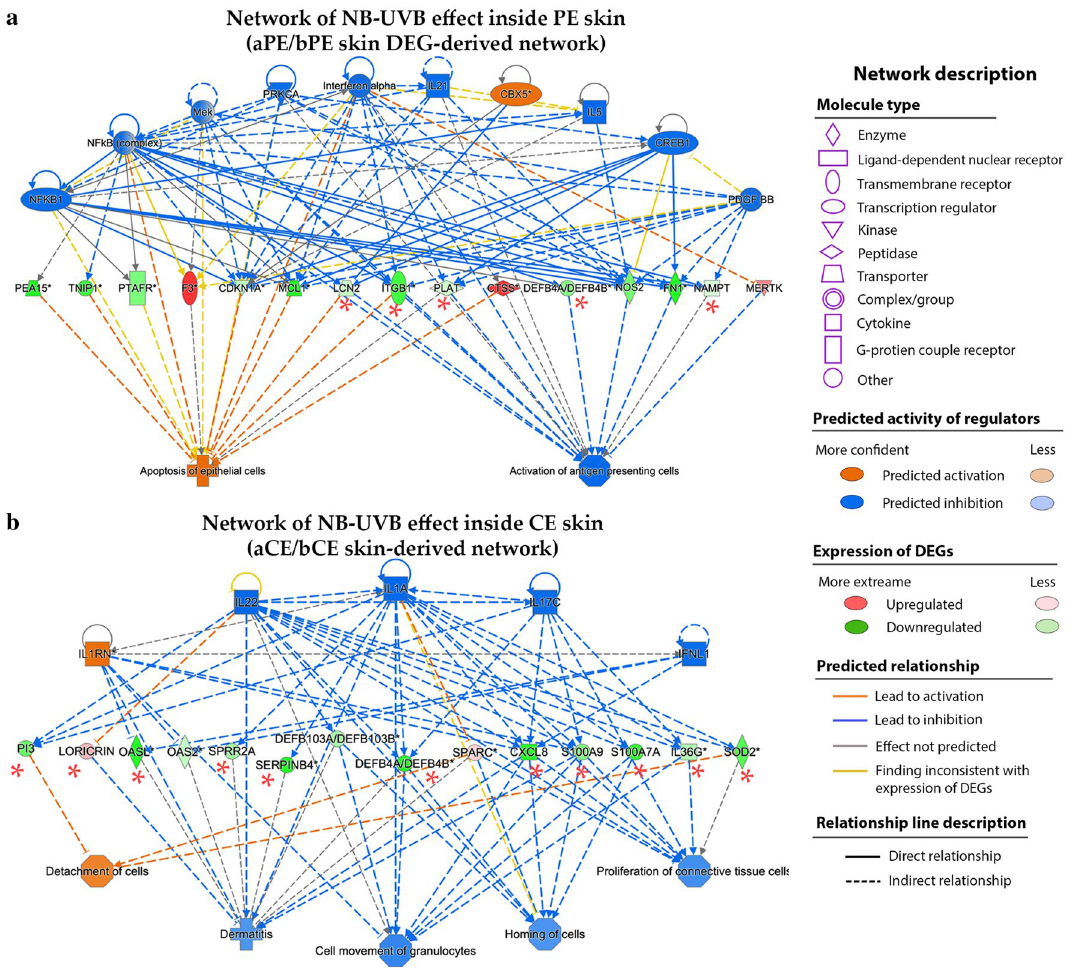
Figure 5. Potential networks for the molecular effect of NB-UVB. ( a ) Molecular network of NB-UVB effect in the PE skin. ( b ) Molecular network of NB-UVB effect in the CE skin. *indicates plaque-specific DEG. Regulator effect function of QIAGEN’s IPA was used to analyze the networks by overlapping the upstream regulators molecules to DEGs and their downstream functions. aCE skin After-treatment CE skin, aPE skin After- treatment PE skin, bCE skin Before-treatment CE skin, bPE skin Before-treatment PE skin, DEGs Differentially expressed genes, NB‑UVB Narrow band ultra violet